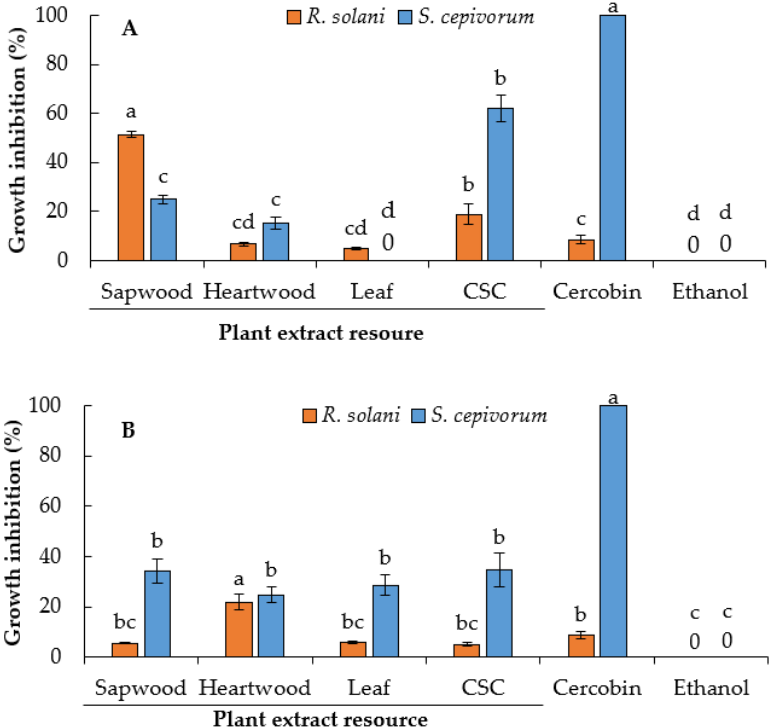
Figure 6. Effect of different source extracts of Eysenhardtia platycarpa on inhibition of mycelial growth of Rhizoctonia solani and Sclerotium cepivorum after 72 h of culture. ( A ) Fatty hexane extract; ( B ) defatted hexane extract. CSC: Cell suspension culture. Values represent mean ± standard deviation of three replicates. Bars followed by the same letter between the same fungus are not significantly different ( p = 0.05) using Tukey’s multiple range test.